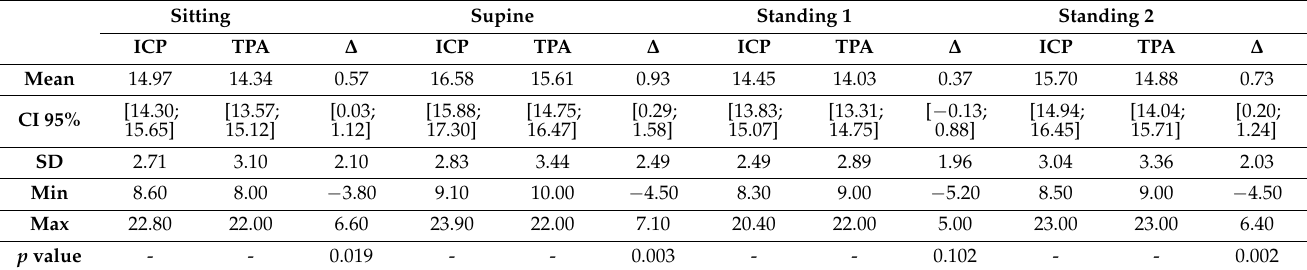
Table 1. Comparison of intraocular pressure (IOP) measurement obtained in different positions both with Icare PRO (ICP) and Tono-Pen AVIA (TPA), with evaluation of difference of IOP measurements between ICP and TPA in each position. CI 95% = 95% confidence interval from the mean; SD = standard deviation; Min/Max = minimum and maximum measurement. p value = level of significance obtained by Paired T-test. ∆ = Difference between ICP and TPA. All IOP parameters were reported in